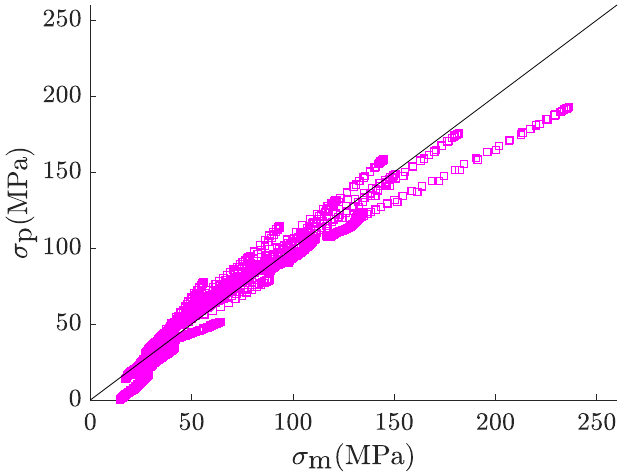
Figure A4. The correlation between σ m and σ p using the exponential model.